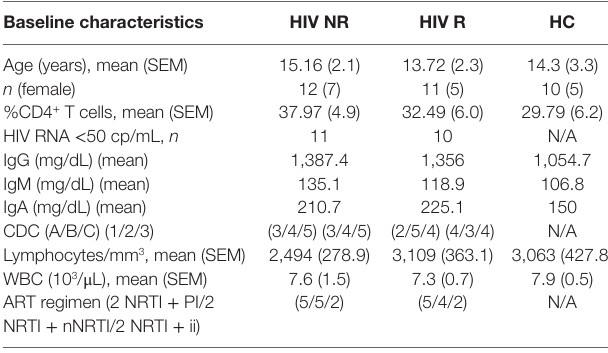
TaBle 1 | Characteristics of study